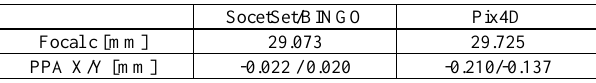
Table 1: Swinglet camera